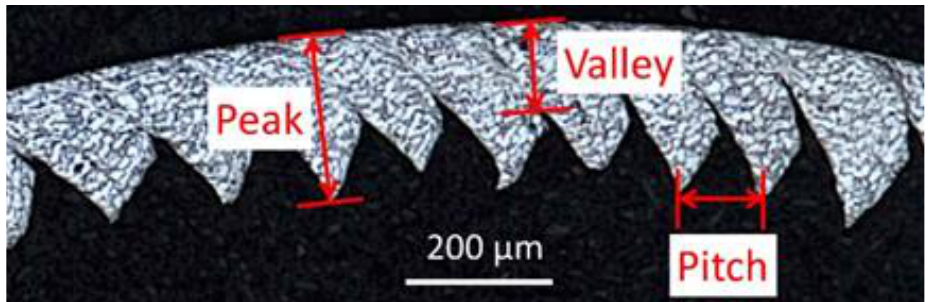
Figure 2. Parameters of the chip geometry measured by optical microscope.